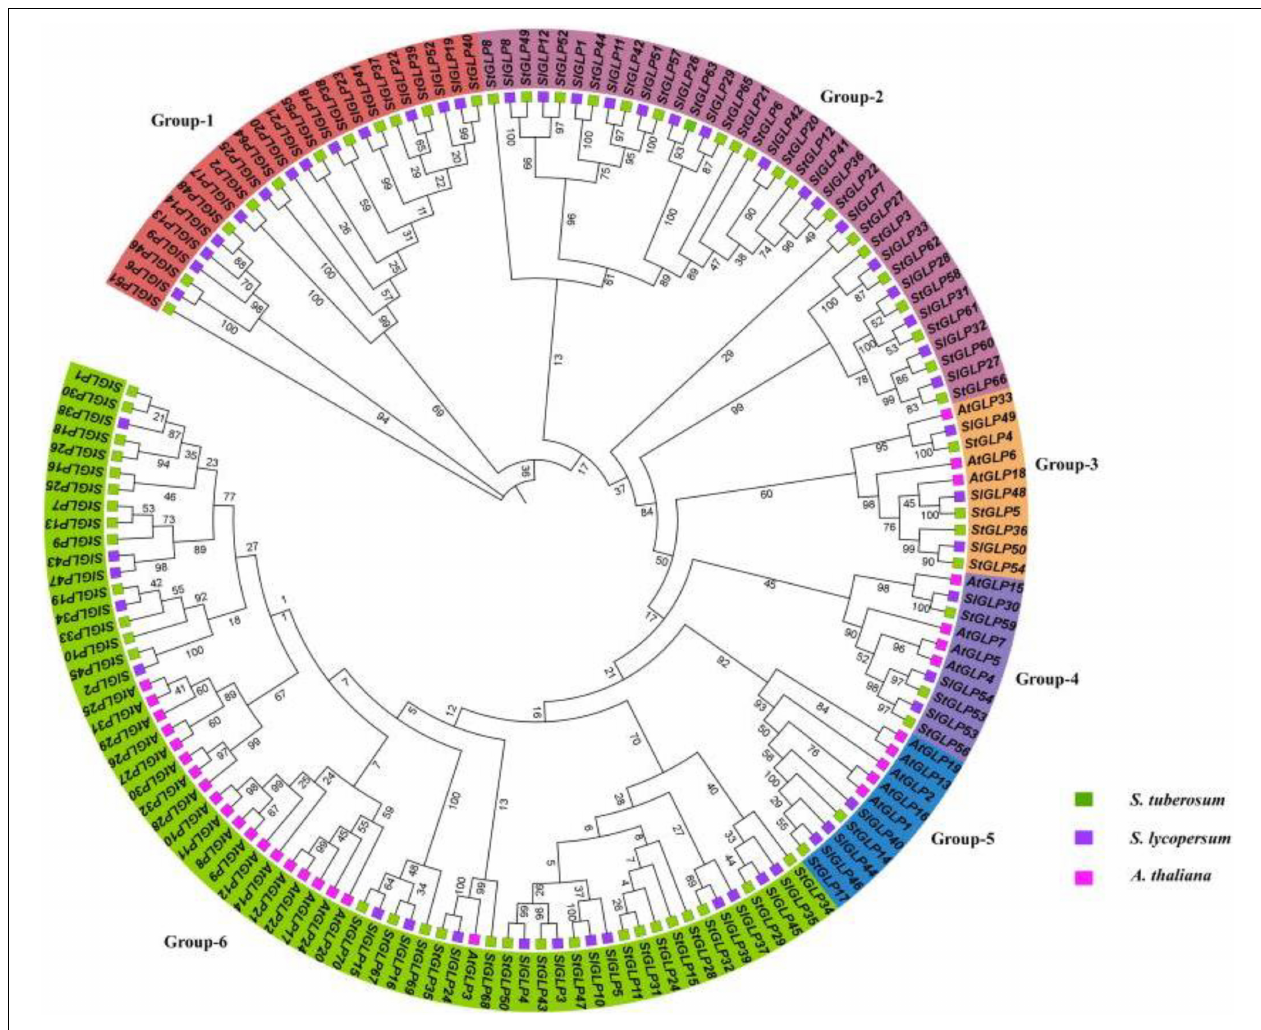
FIGURE 1 | Phylogenetic tree of GLP proteins from Arabidopsis , S. lycoperiscum , and S. tuberosum . The colored arcs indicate different groups. The stars colors represent proteins of Arabidopsis , S. lycoperiscum , and S. tuberosum .